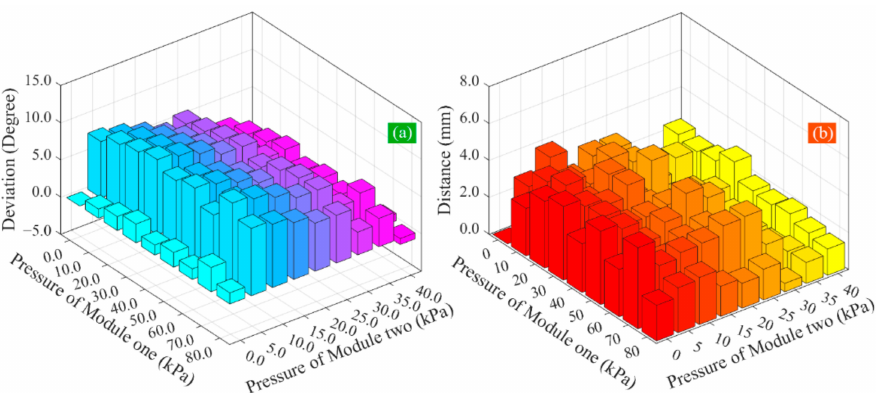
Figure 11. Comparison of the calculated and measured results: ( a ) bending angle and ( b ) location of the actuator’s tip.